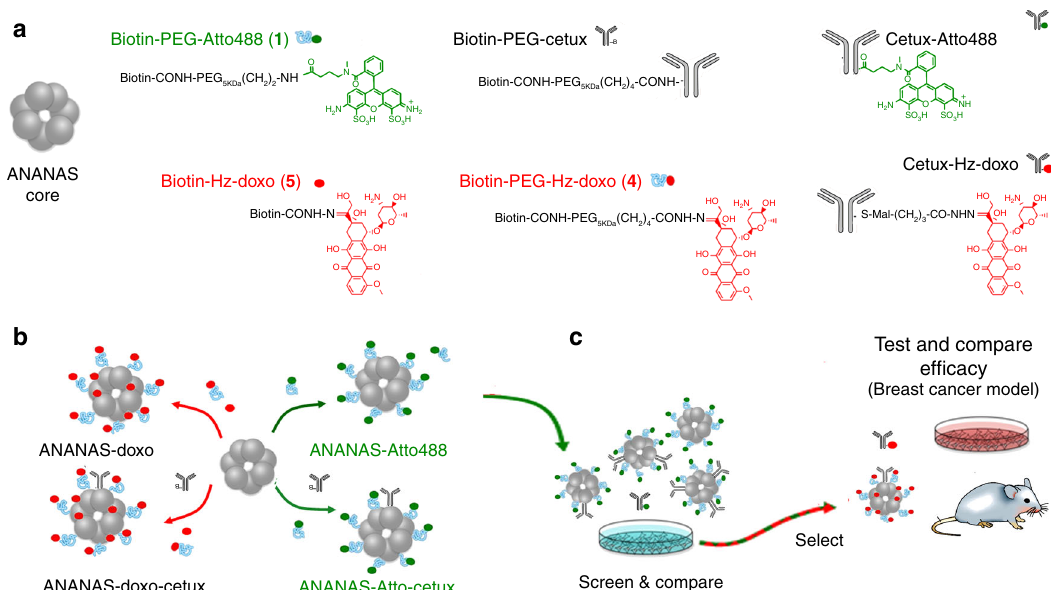
Fig. 1 ANANAS assembly and study design. a The building blocks for ANANAS functional assembly and the reference antibody conjugates synthesized for this work; b ANANAS functional assembly and c in vitro and in vivo